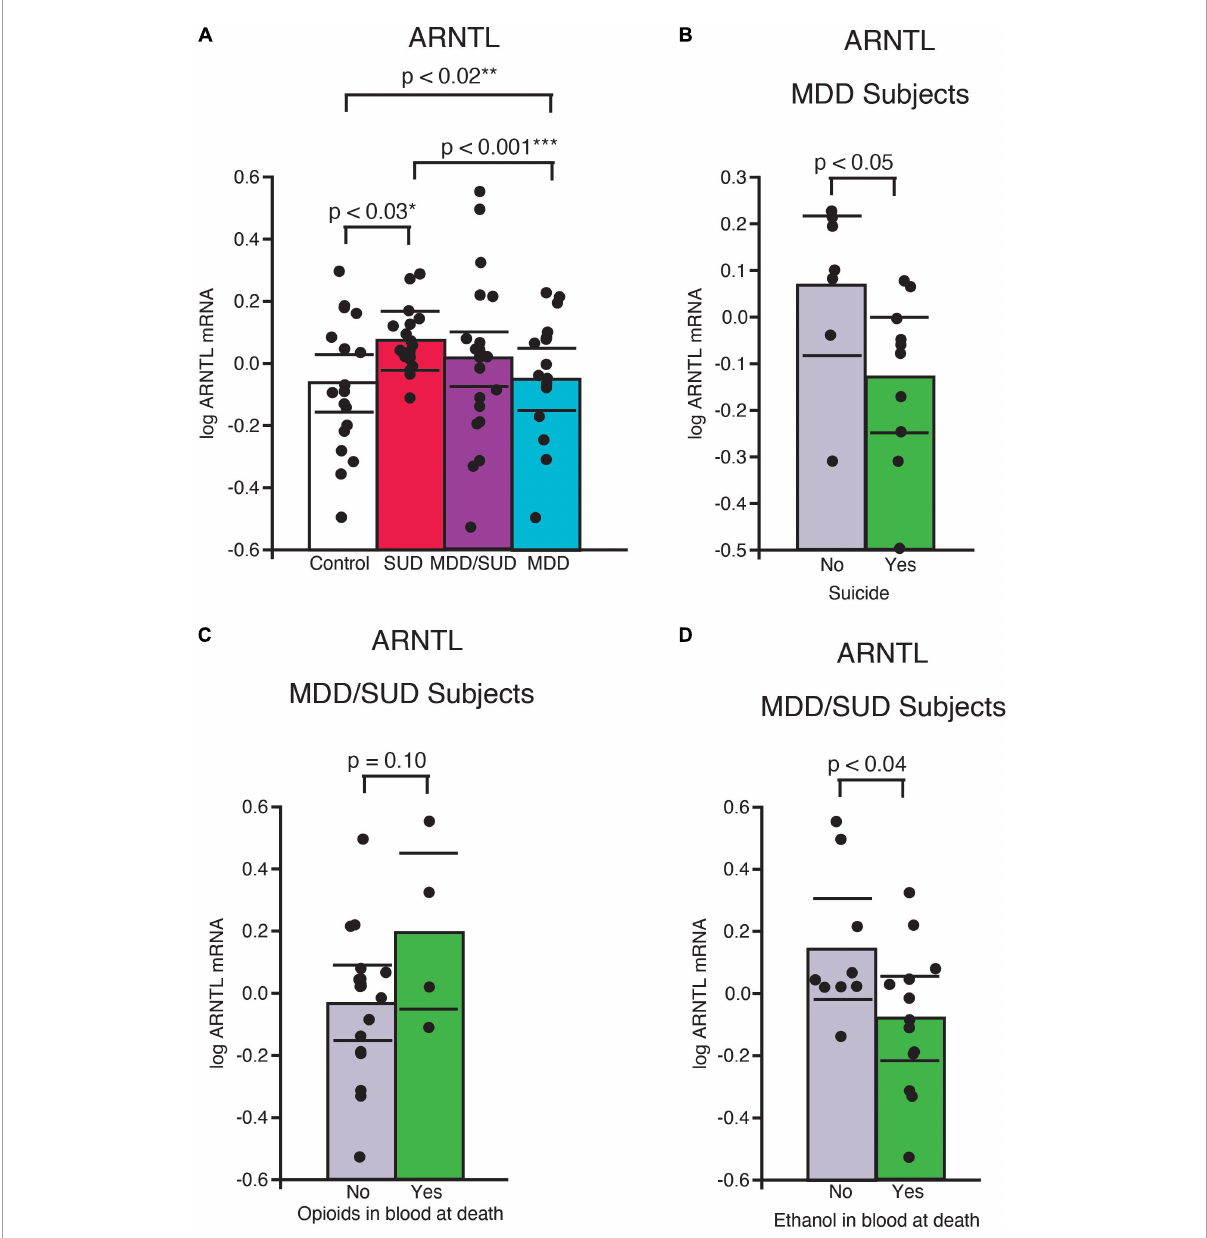
FIGURE3 ARNTL expression is differentially altered in the hippocampus of subjects with SUD and subjects with MDD. (A) Arntl mRNA expression was significantly greater in subjects with SUD compared to control subjects ( p < 0.03, *adjusted for significant effects of ZT time and interaction of ZT time with diagnosis). A significant decrease in Arntl mRNA expression was observed in subjects with MDD only compared to control subjects ( p < 0.02, **adjusted for significant effects of ZT time, duration of illness, and age). Subjects with MDD also displayed lower Arntl expression compared to subjects with SUD ( p < 0.001, ***adjusted for significant effects of ZT time and duration of MDD). Subjects with MDD who died by suicide had significantly less ARrntl mRNA expression than subjects with MDD who died from other causes (B) . Subjects with MDD/SUD with opioids in the blood at death had a non-significant trend toward increased Arntl expression (C) compared to significantly less Arntl expression in subjects with ethanol in the blood at death (D) . Significance values are derived from stepwise linear regression models. Scatterplots show the mean (histogram) and 95% confidence intervals (black lines).